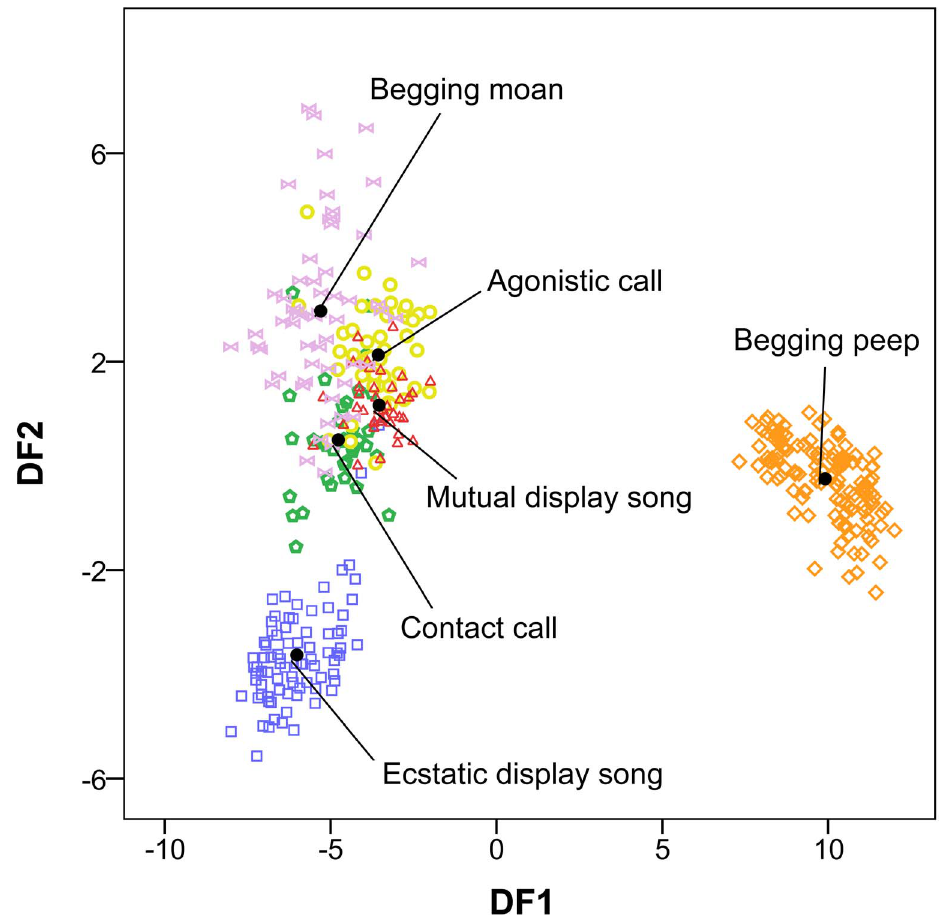
Figure 2. Plot of the discriminant scores generated by the first two discriminant functions to classify vocalisations of the African Penguin. Black dots are the centroids of the vocal categories.